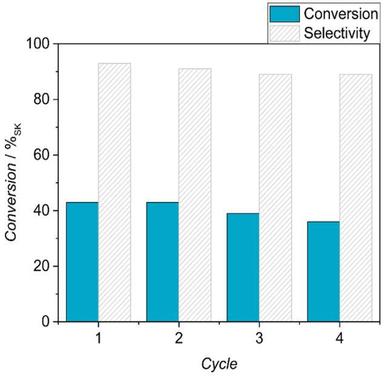
Recycling tests using Ga-74.